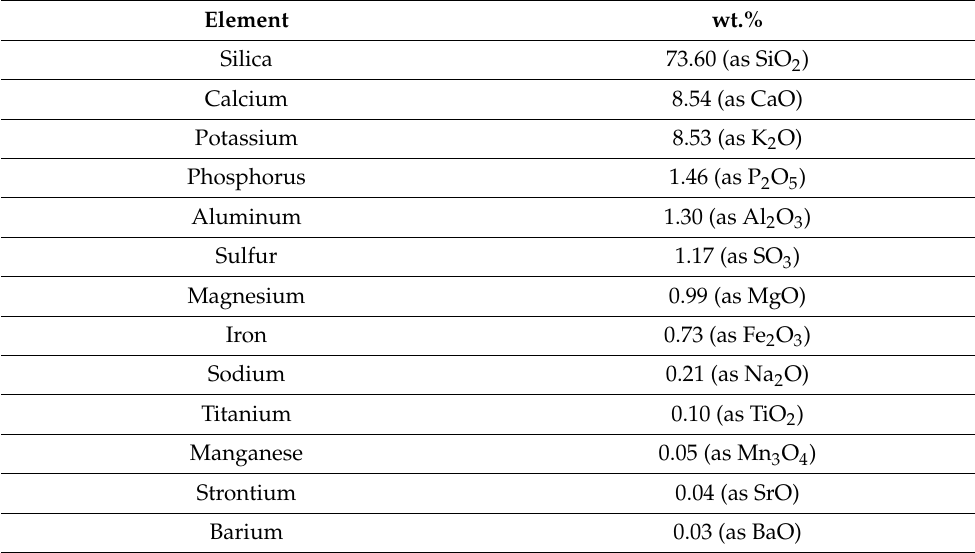
Table 1. Elemental composition of straw biomass used as a fuel. Element